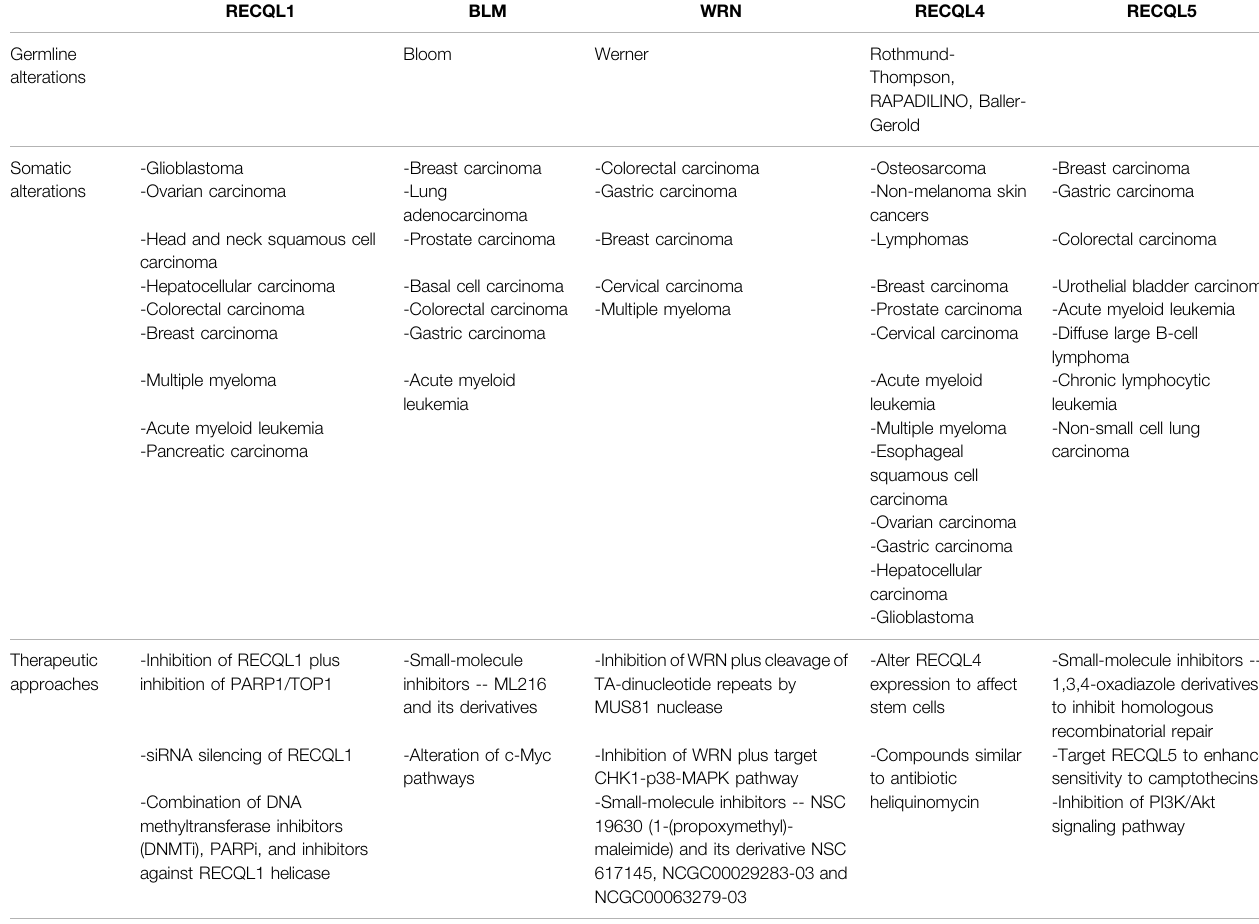
TABLE 1 | Summary of germline and somatic alterations in RecQ helicases with potential anti-cancer therapeutic